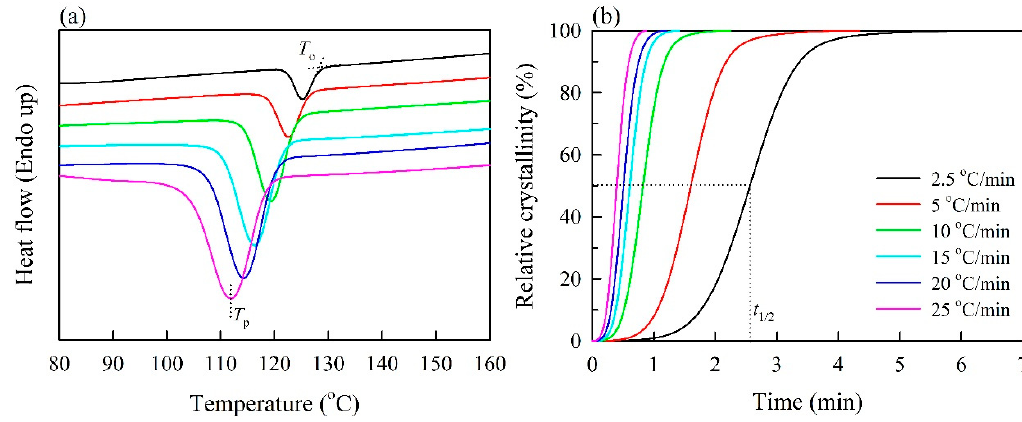
Figure 1. Nonisothermal crystallization behaviors of polypropylene with unmodified bamboo fibers. ( a ) Differential scanning calorimetry (DSC) thermograms. ( b ) Relative crystallinity as a function of time. Table 2. Nonisothermal crystallization parameters as a function of cooling rate for polypropylene with unmodified and acetylated bamboo fibers.